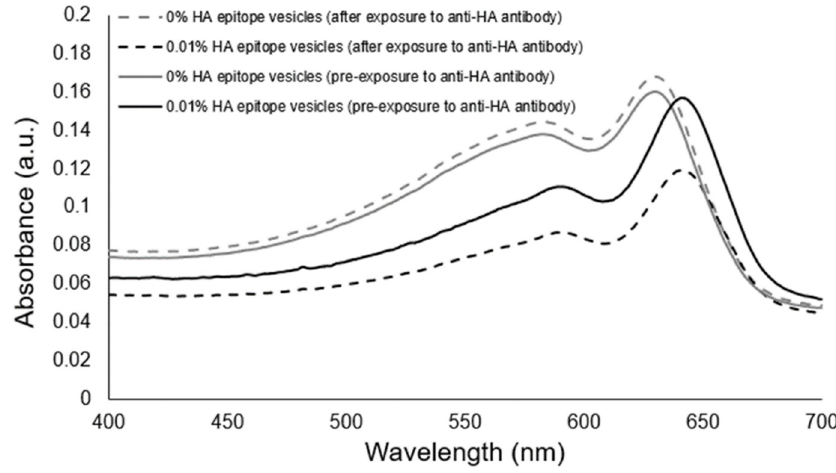
Figure 5. Examination of aggregation response to the presence of soluble anti-HA antibody for 0.01% HA epitope-displaying vesicles compared to the no-HA epitope control vesicles.